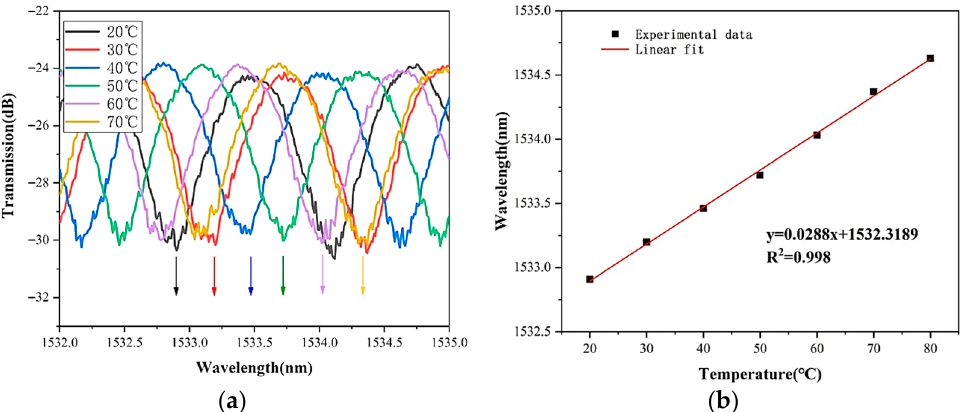
Figure 10. ( a ) The wavelength variation of the MZI dip with temperature increasing from 20 °C to 70 °C; ( b ) The linear fit of the MZI dip about the sensitivity of 28.8 pm/°C. By observing the variation in the dip wavelength of the anti-resonance effect, it can be found that the intensity of the anti-resonance wavelength is almost not affected by temperature, as shown in Figure 11a. The inset is an enlarged view of the dip shift with temperature change. Gaussian fit is also used in the temperature measurement to extract the resonant wavelength, and the linear fit of the experimental data in Figure 11b indicates that the temperature sensitivity of the resonant wavelength intensity is − 0.018 dB/°C. This shows that when using intensity demodulation of a resonant wavelength for curvature sensing, the temperature cross-sensitivity as low as 0.0025 m − 1 /°C can be achieved.